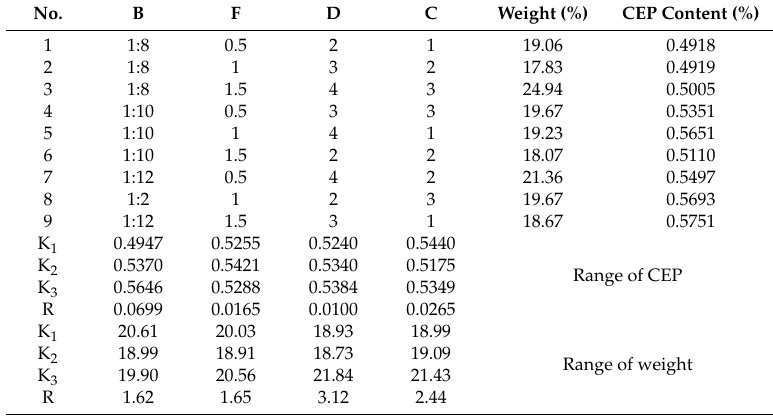
Table 1. Design and results of orthogonal test of extraction process optimization on extraction yield and CEP content from Stephania cepharantha